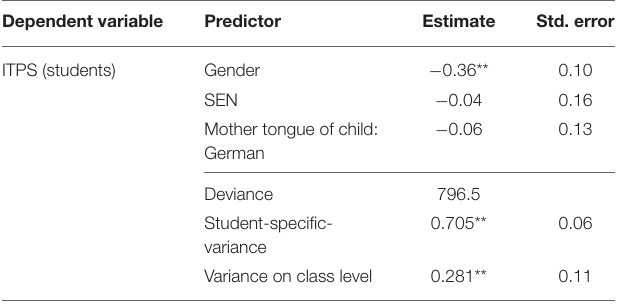
TABLE 4 | Estimates of the multi-level regression model analyses to predict students’ rating (the second model). Dependent variable